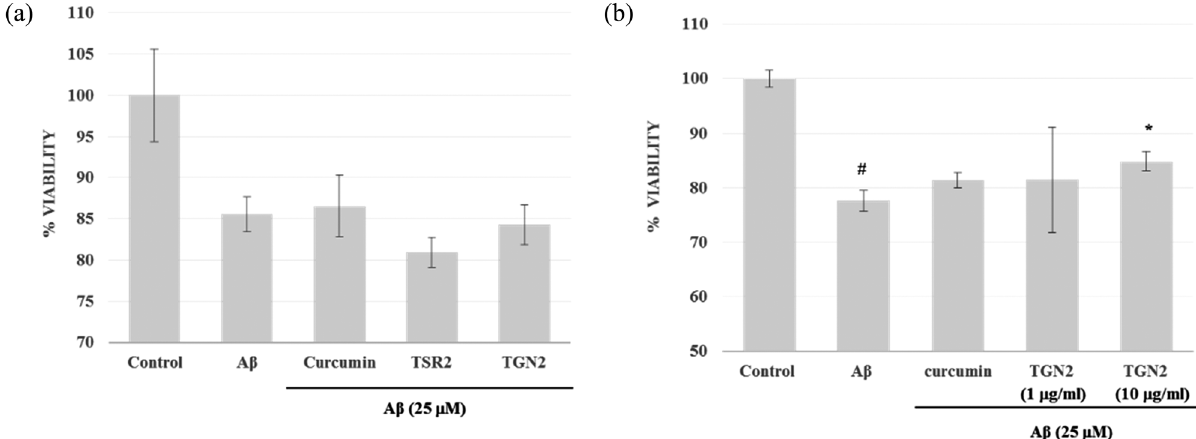
Figure 4: Neuroprotective e ff ects of dual activity compound against A β induced cytotoxicity: ( a ) the screening results at the nontoxic concentration of 100 µg/mL; ( b ) neuroprotective e ff ects of TGN2 . Data are mean ± SD ( n = 3 ) , # p < 0.01 compared with the control group and * p < 0.01 compared with the A β - treated group ( paired t - test statistic from Microsoft Excel )